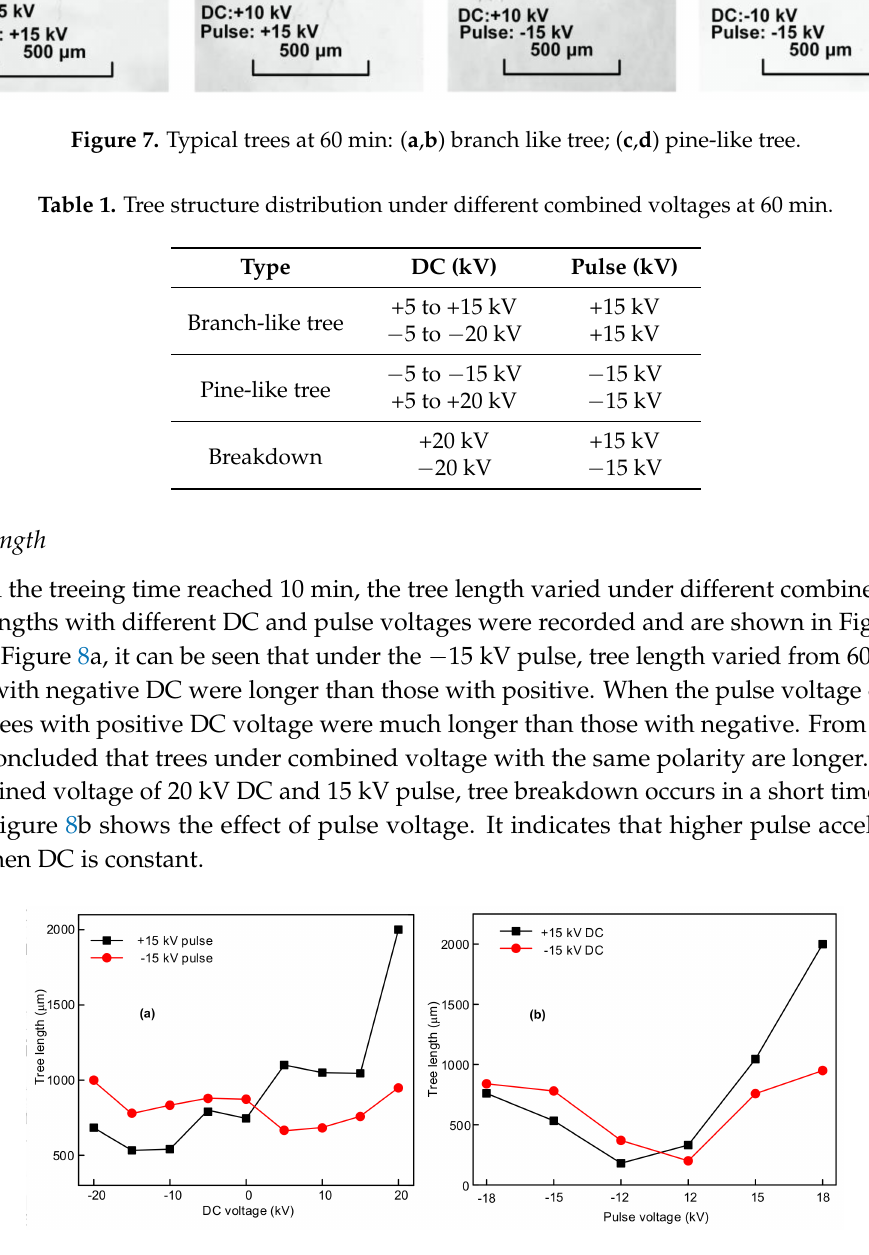
Figure 8. Effect of pulse and DC voltage on tree length: ( a ) tree length under different DC voltages; ( b ) tree length under different pulse